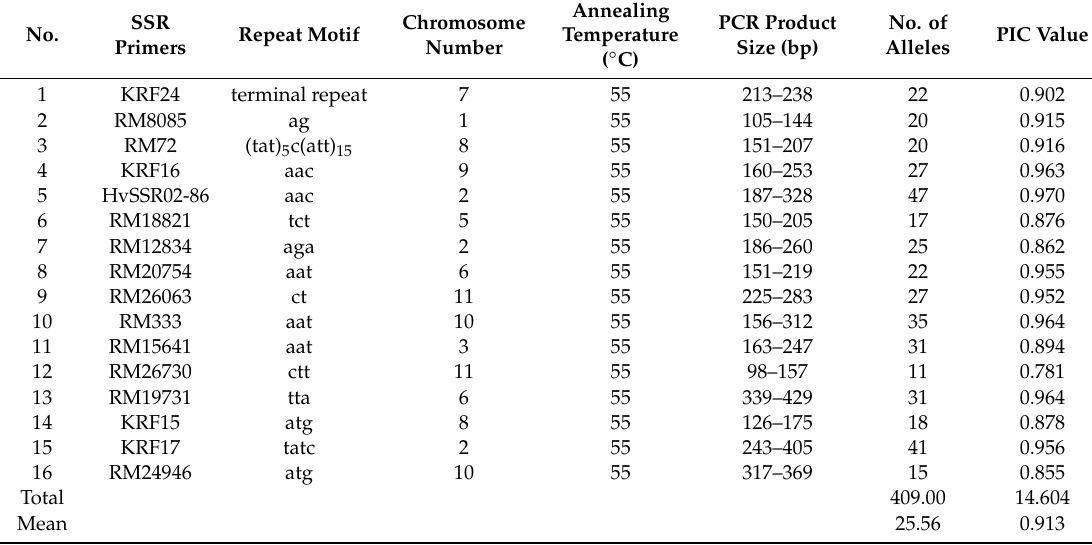
Table 1. Repeat motif, no. of alleles, and polymorphism information content (PIC) value of microsatellite markers selected for genetic characterization of rice cultivars and